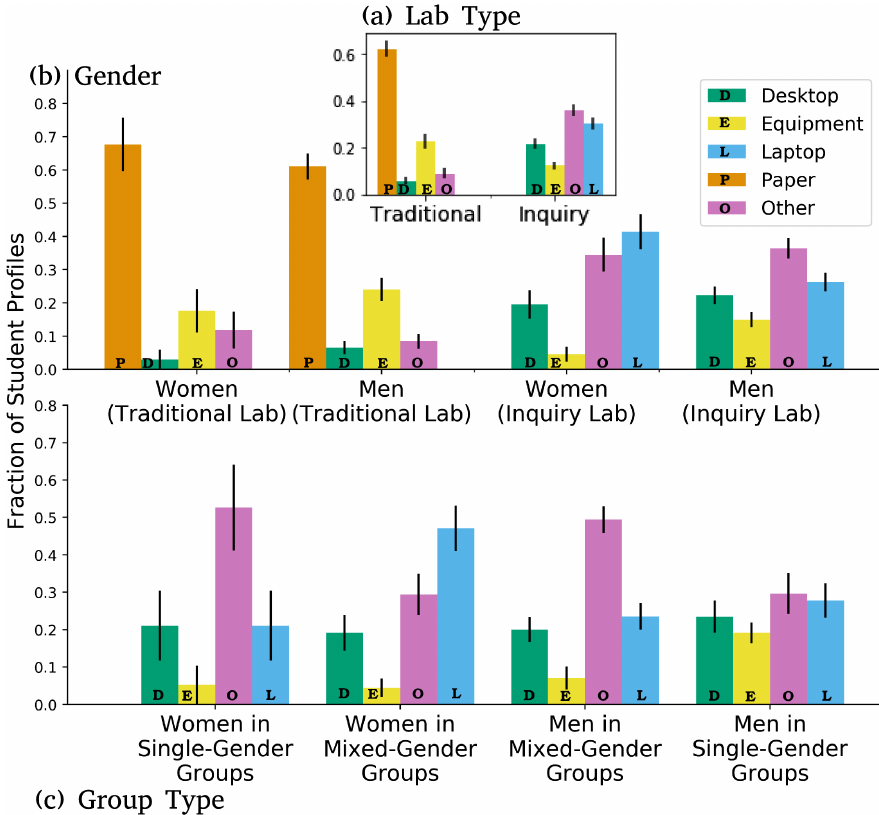
FIG. 6. Cluster compositions for each of the five clusters, broken down both by lab type, gender, and group composition. In all plots, the y axis represents a fraction of student profiles and errors are calculated using the standard error on the fraction of a population shown [see Eq. (1) for additional details]. (a) Cluster distributions broken down by lab type. (b) Clusters further broken down by gender. We see that there are disproportionately more women in the laptop cluster than men, and disproportionately more men than women in the equipment cluster. (c) Cluster distributions were further broken down in the inquiry lab by group type (men and women in mixed-gender groups and single-gender groups). Upon inspection, we see that the laptop difference remained, while a difference emerged in other. Furthermore, far more men are high-equipment users when in single-gender groups. Because of insufficient statistics, no comparison can be made with women in single-gender groups, and the data are presented for